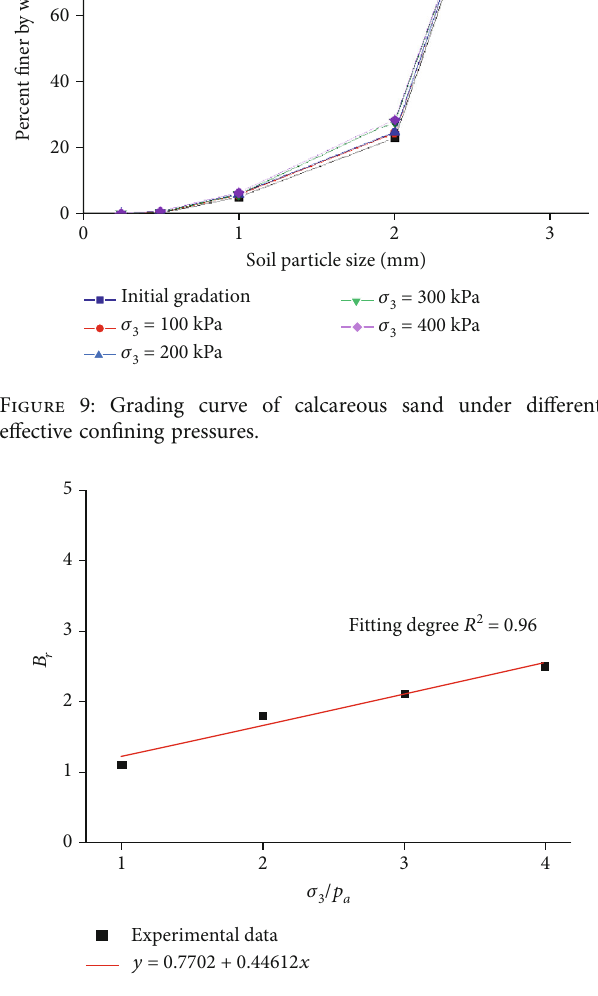
Figure 10: Calcareous sand B